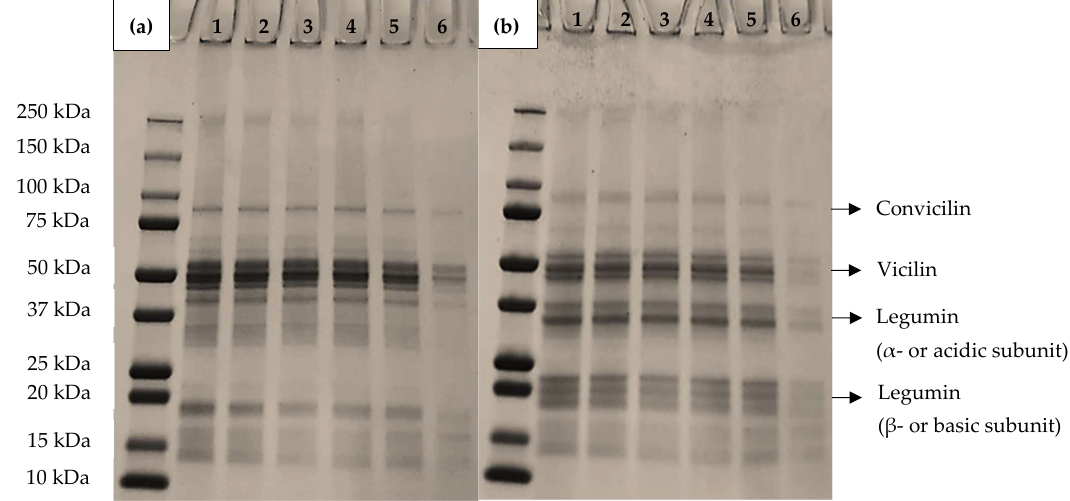
Figure 7. Representative sodium dodecyl sulphate-polyacrylamide gel electrophoretograms (SDS-PAGE) of the serum phase after centrifugation of lentil protein-stabilised emulsions with calcium chloride concentrations of 0 mM (1), 2 mM (2), 3 mM (3), 4 mM (4), 5 mM (5) and 6 mM (6) under nonreducing ( a ) and reducing ( b ) conditions. The sample with 10 mM calcium chloride added was not included in the Figure as no bands were detected in the gel. The first lane of the gel contains the molecular weight marker (MW).